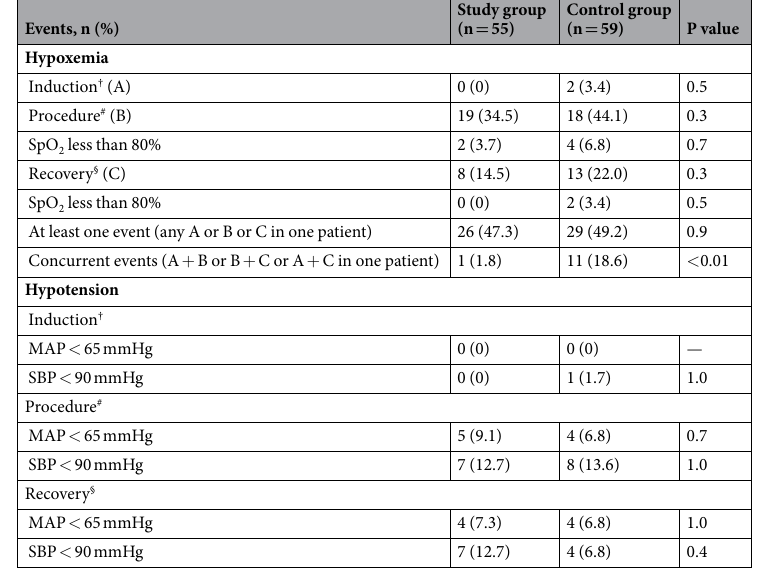
Table 2. Events of hypoxemia and hypotension during bronchoscopic sedation * . Data are presented as number and percentage. Abbreviations: SpO 2 : oxyhemoglobin saturation; MAP: mean arterial pressure; SBP: systolic blood pressure. * The proportions of patients with at least one event of hypoxemia (SpO 2 < 90%) or hypotension (MAP < 65 mmHg or SBP < 90 mmHg) during the entire procedure. † From administration of propofol to the time point of Ce of induction. # From insertion of bronchoscope to removal. § Duration between complete bronchoscopy and regain